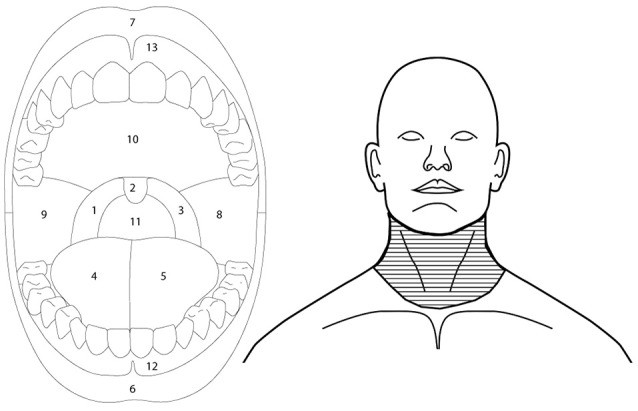
Outlines of the intra-oral (left) and orofacial (right) image used to extract regional somatosensory effects of menthol, nicotine, and cinnamaldehyde. Back of the throat was defined as regions 1, 2, 3, and 11, tongue as regions 4 and 5, and remaining part of the mouth as regions 8, 9, 10, 12, and 13. Lower throat region of the orofacial drawing is indicated by the horizontal line fill.